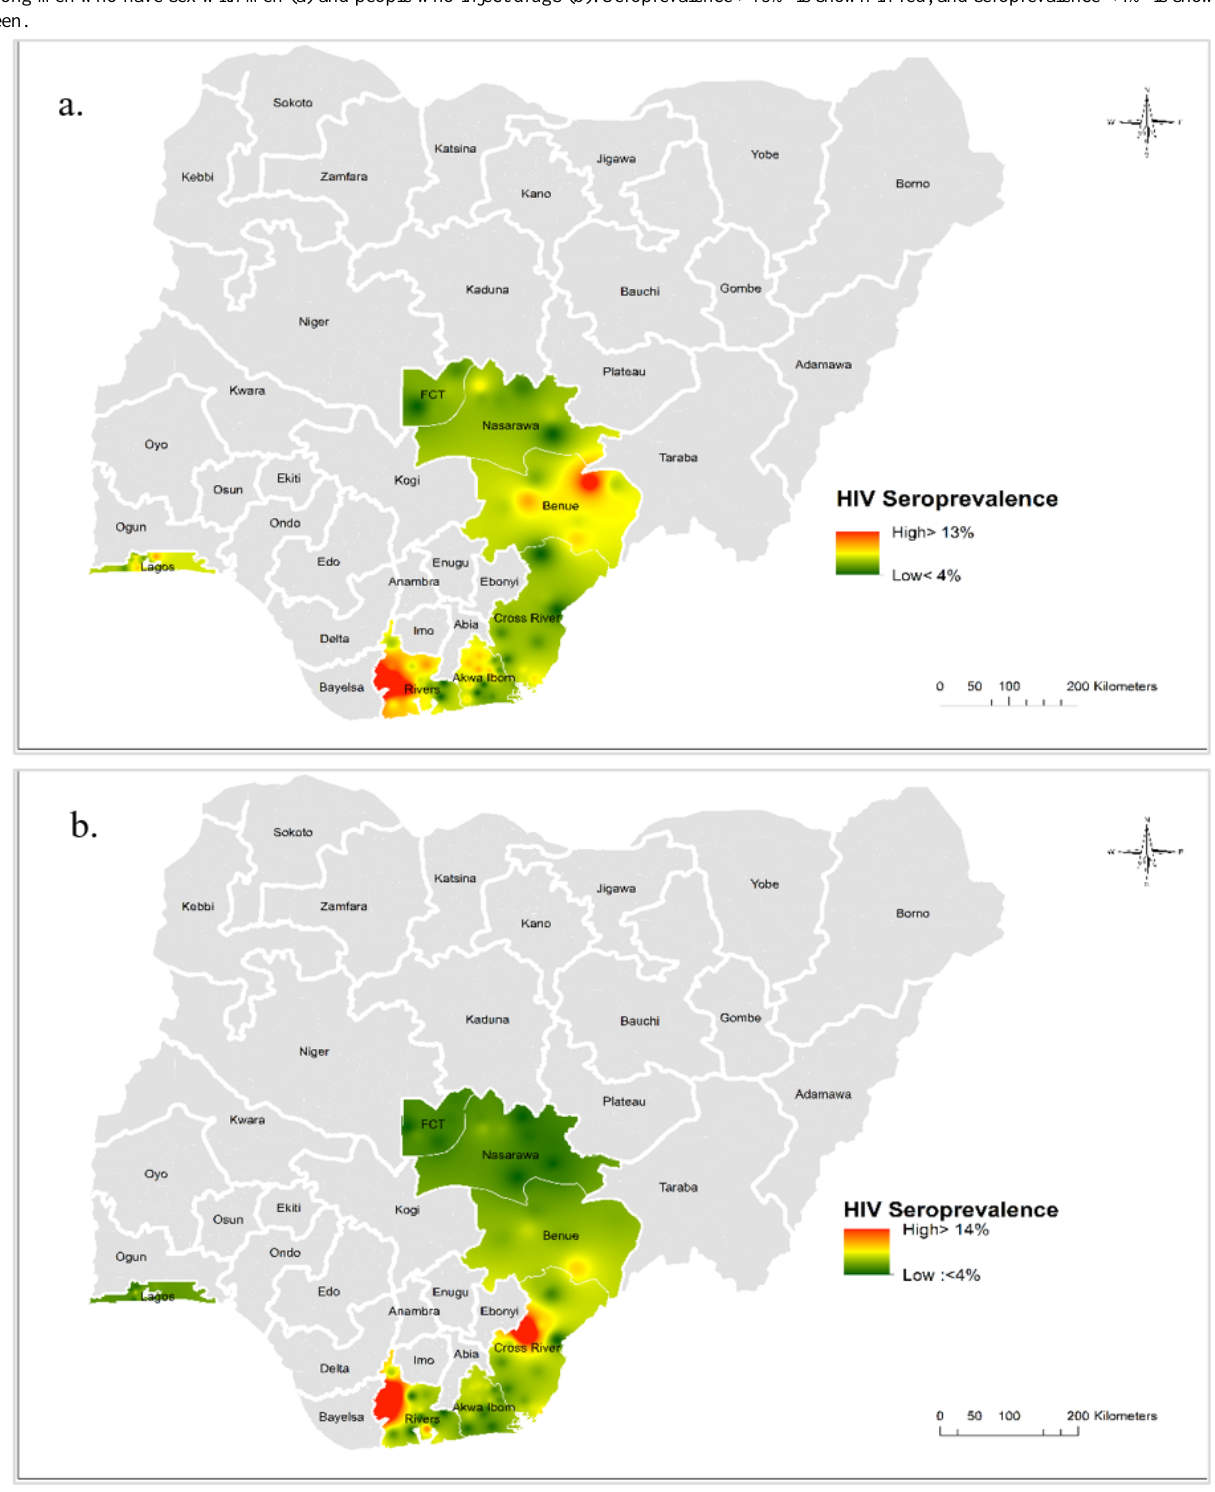
Figure 3. Map of Nigeria showing the interpolated areas with high and low HIV seroprevalence on from October 1, 2016, to September 30, 2017, among men who have sex with men (a) and people who inject drugs (b). Seroprevalence >13% is shown in red, and seroprevalence <4% is shown in